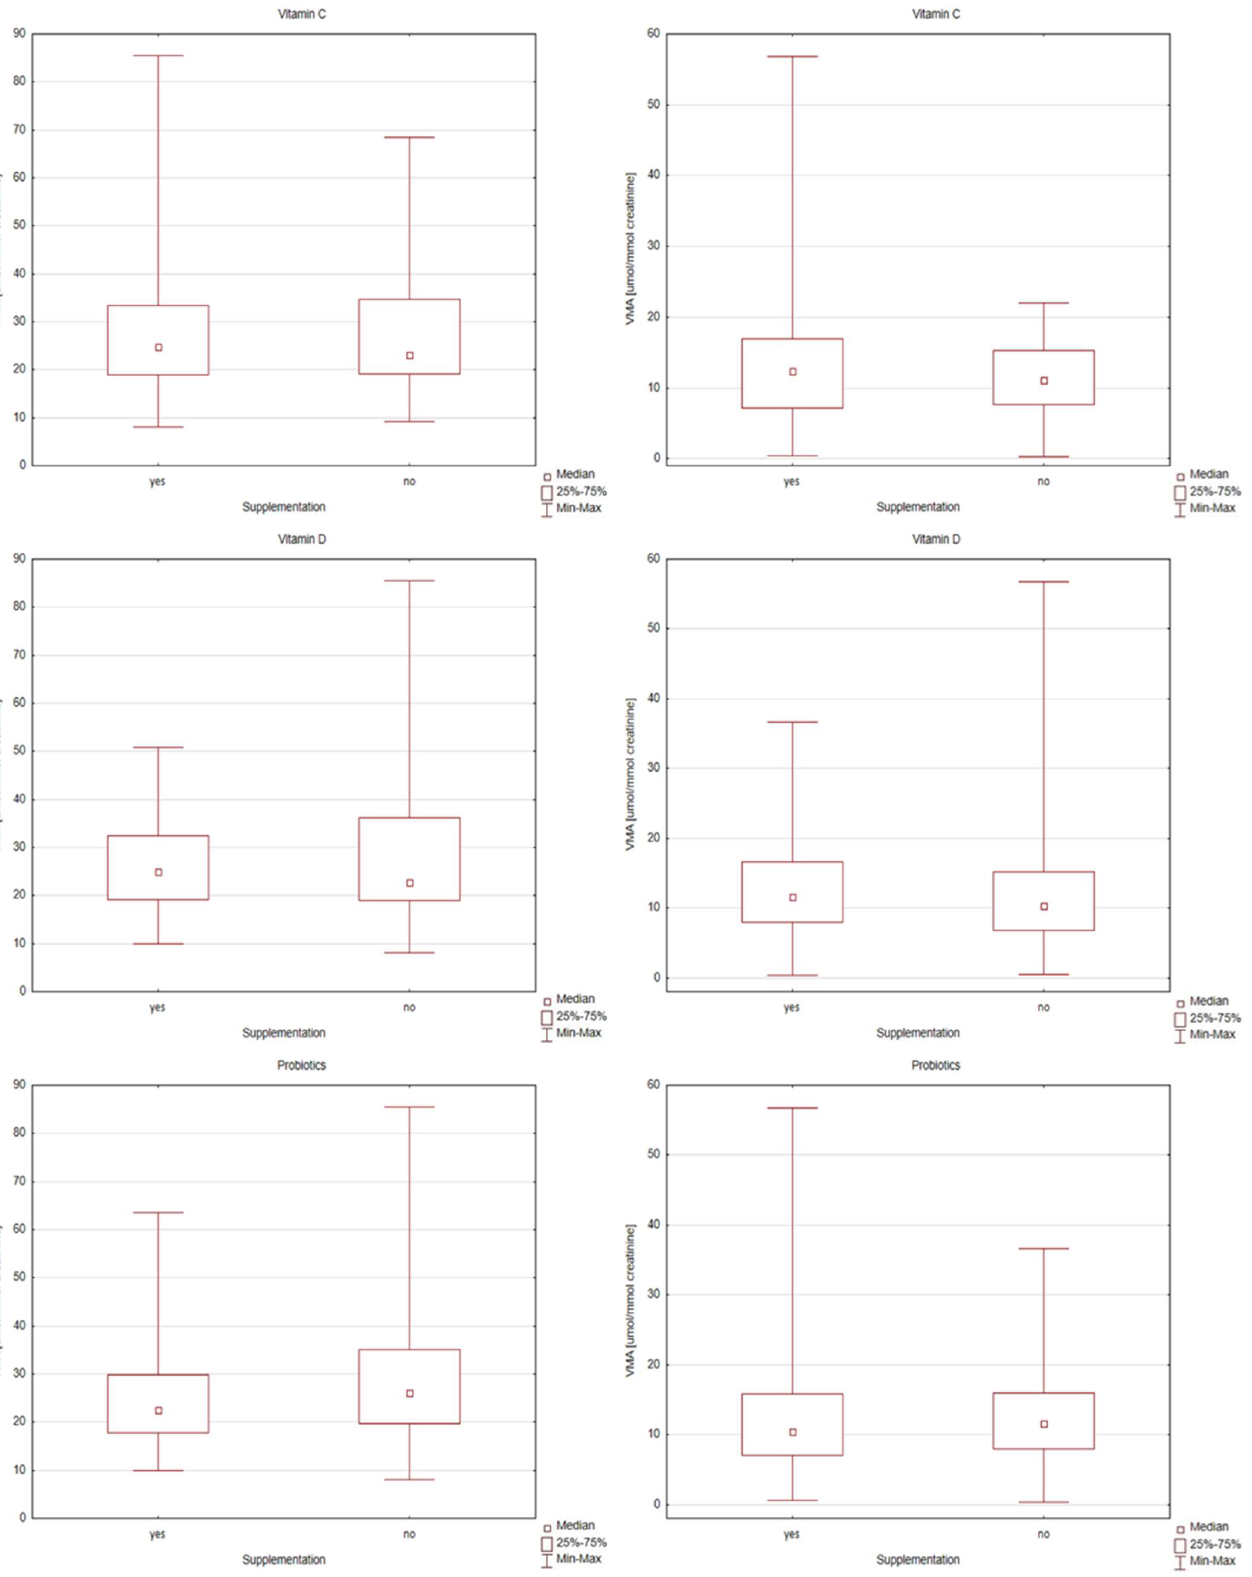
Figure 2. Box and Whisker plots for compounds determined in supplementation-categorized children with autism group (vitamin C, vitamin D and probiotic). In these box plots, medians inside the 25–75% interquartile range (IQR) are presented.